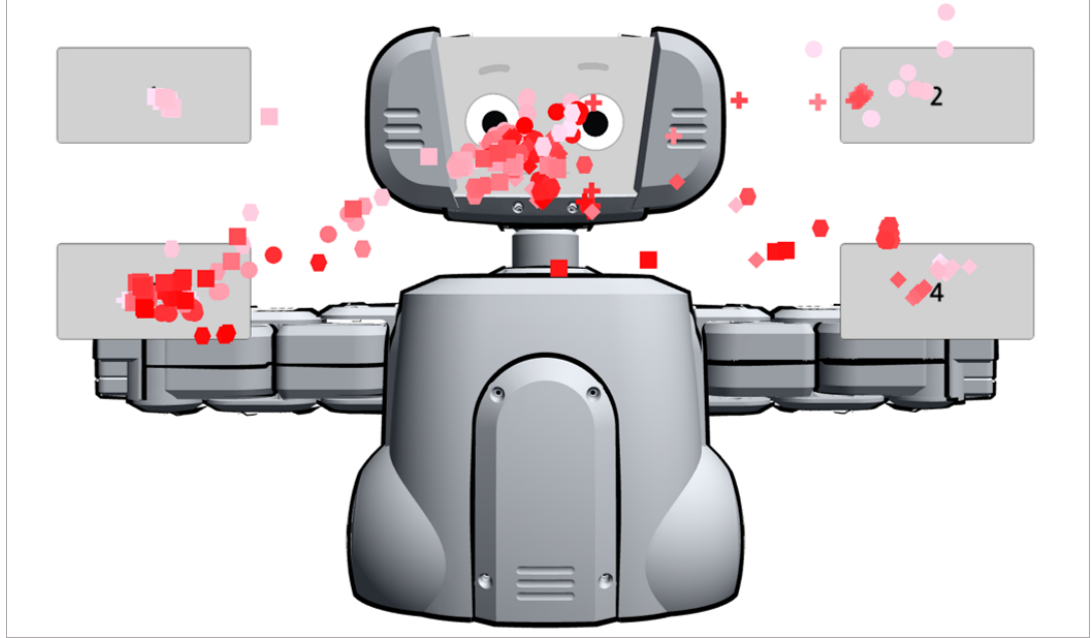
Figure 7. Gaze distributions of selected participants in the LC group: different symbols represent different participants, with increasing color saturation over time. The gaze targets were focused around MOCCA’s face and choice no. 3, which indicates that they recognized the hint toward choice no. 3.